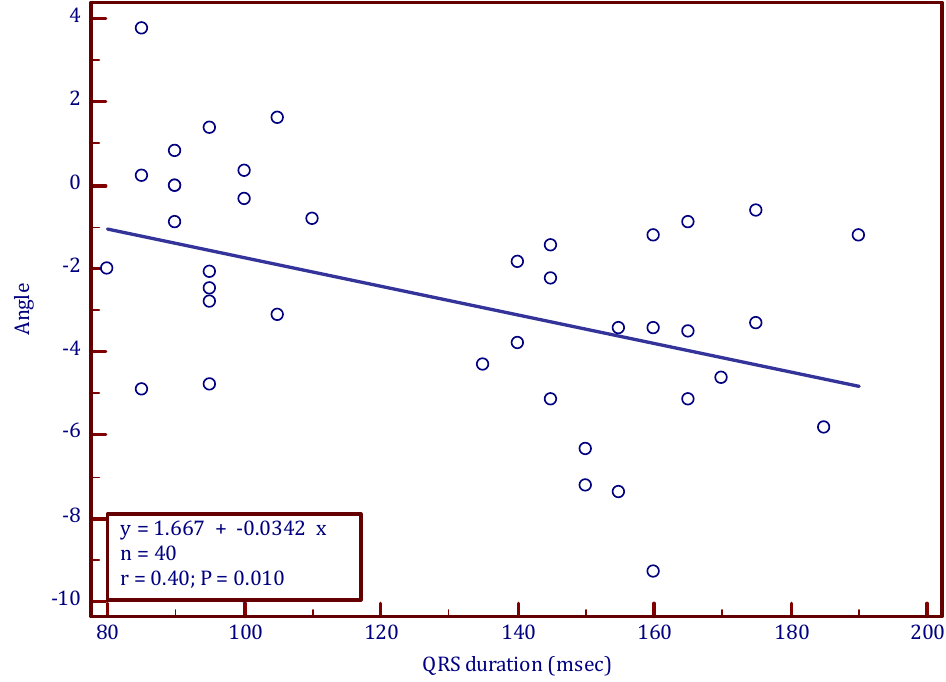
Figure 3. Regression analysis of QRS duration (ms) and longitudinal rotation angle, excluding the CRBBB group.